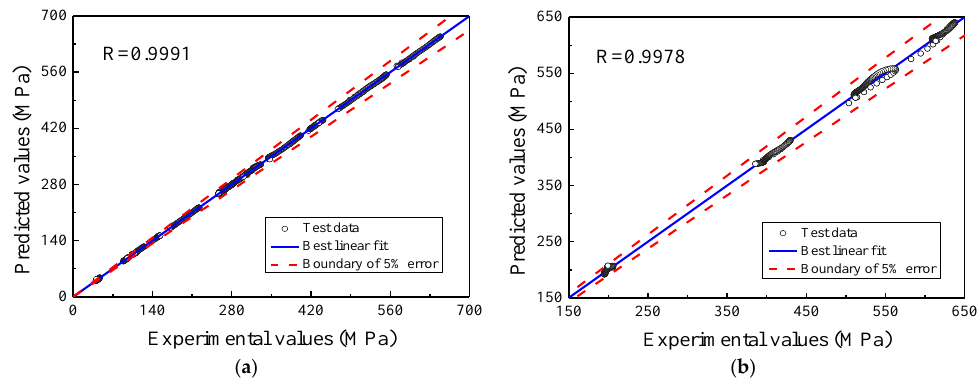
Figure 7. The correlation relationships between the predicted and experimental true stress for the ( a ) training part and ( b ) test part.